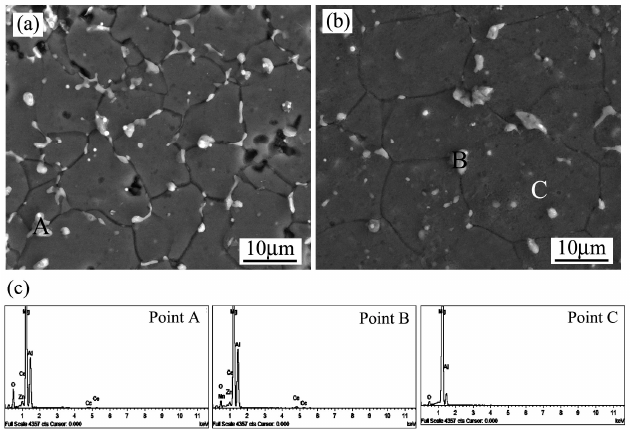
Figure 6. Field emission scanning electron micrographs of spray-casted AZ91D+0.75Ce alloy after annealed at 420 ° C for different times: ( a ) 2 h; ( b ) 8 h; ( c ) EDS spectrums.